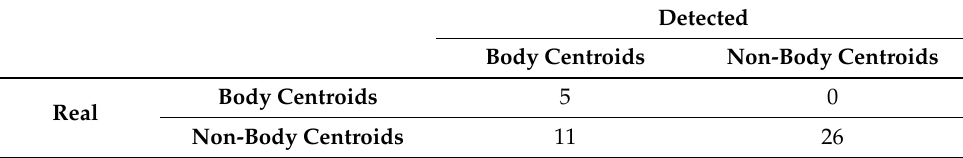
Table 8. The confusion matrix of real and detected body centroids using the maximum entropy TSM.